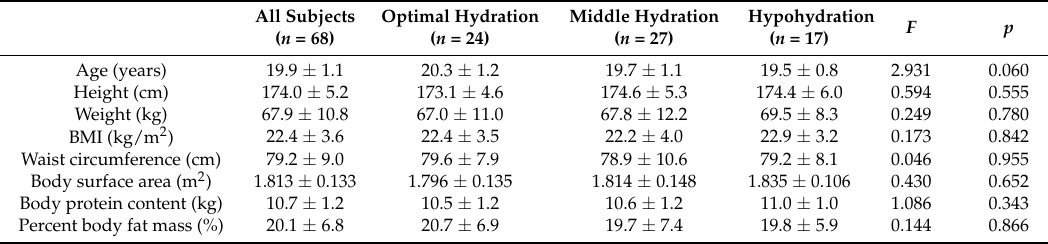
Table 1. Characteristics of the subjects with three hydration